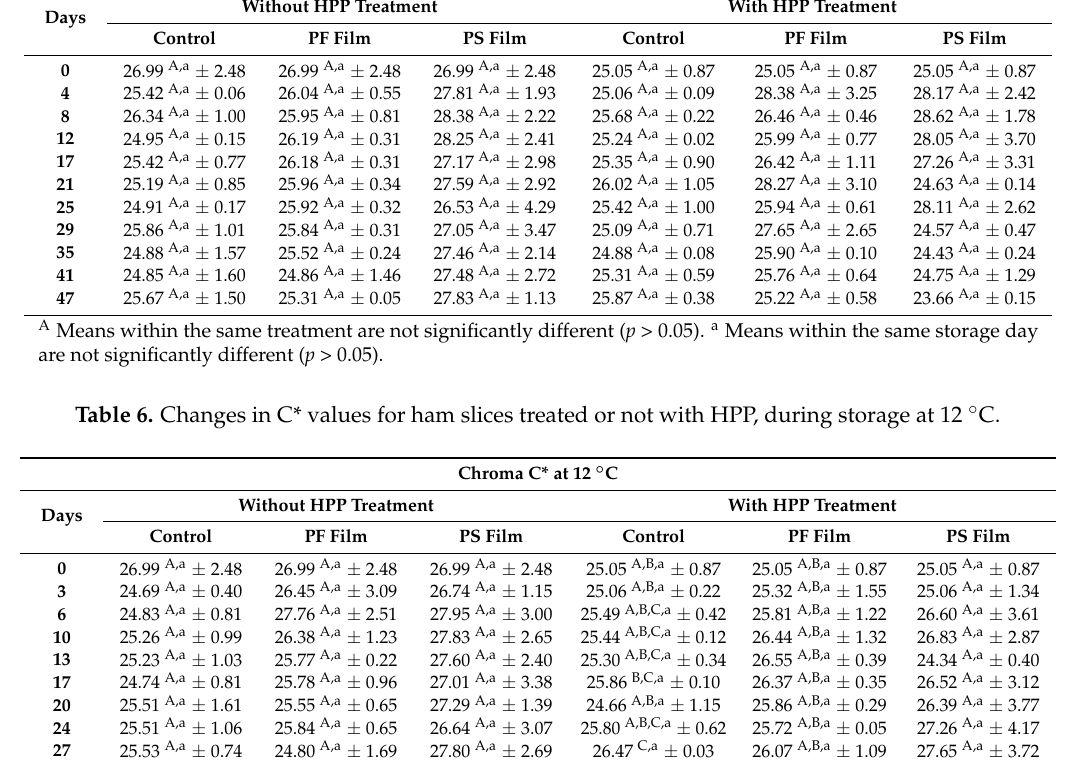
Table 5. Changes in C* values for ham slices treated or not with HPP, during storage at 8 ◦ C. Chroma C* at 8 ◦ C